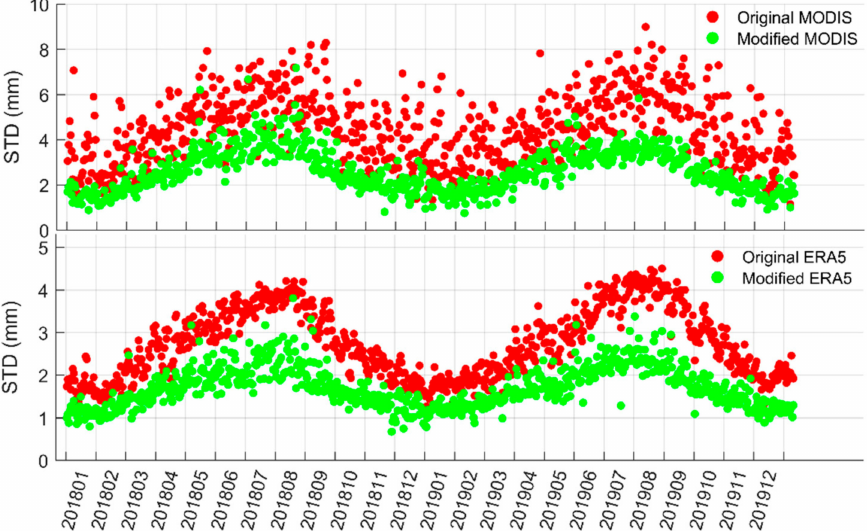
Figure 7. Daily PWV STD of the original MODIS (ERA5) PWV and the modified MODIS (ERA5)